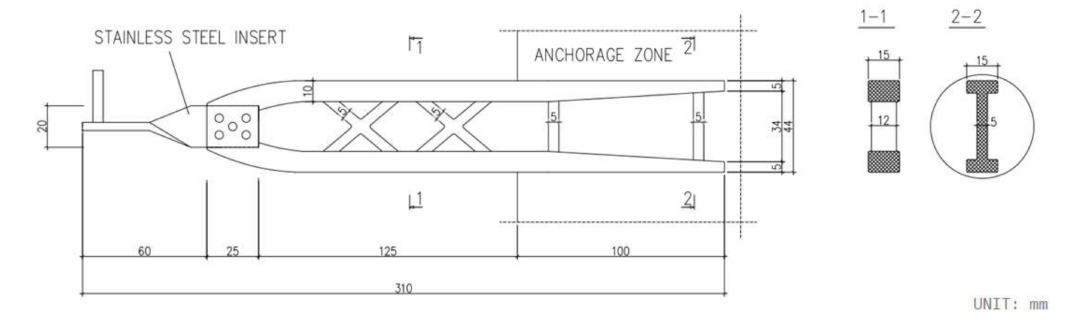
Figure 19. Design of anchor for fastening building